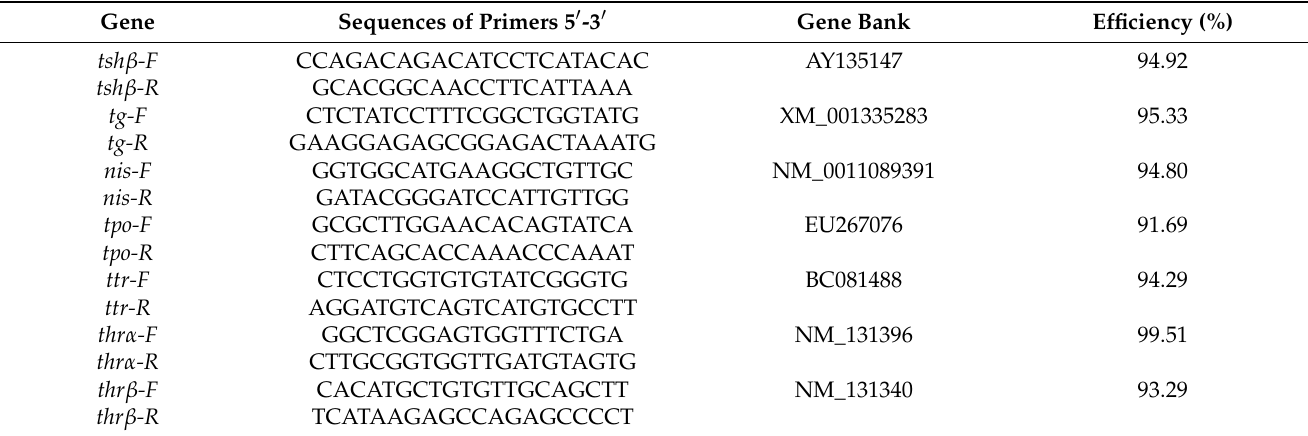
Table 1. Primer sequences used for RT-PCR in this